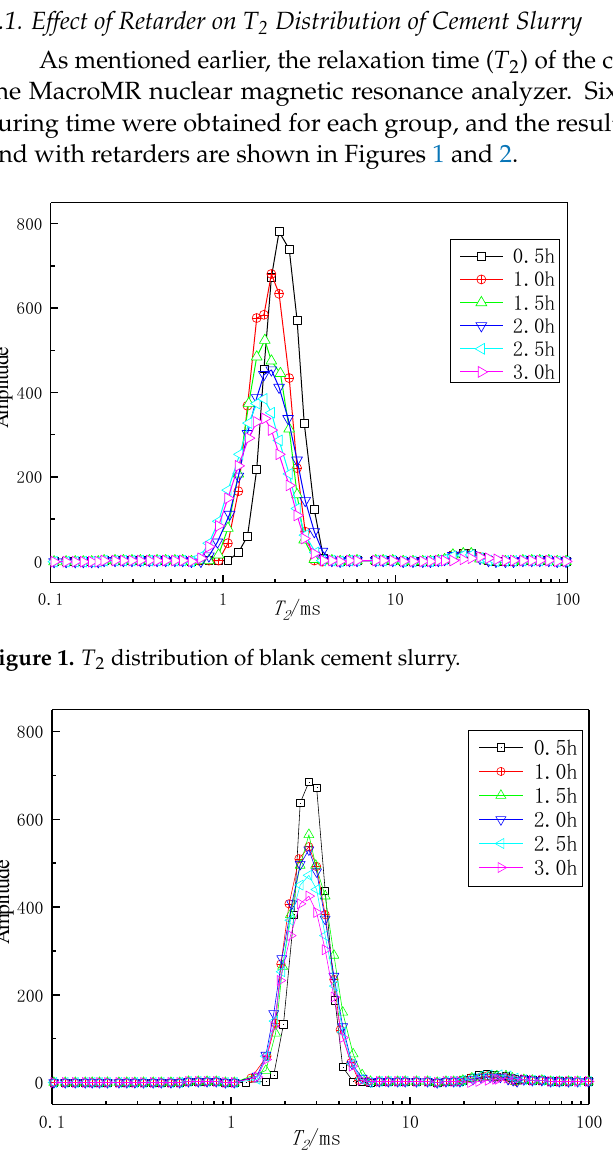
Figure 2. T 2 distribution of cement slurry with the retarder.